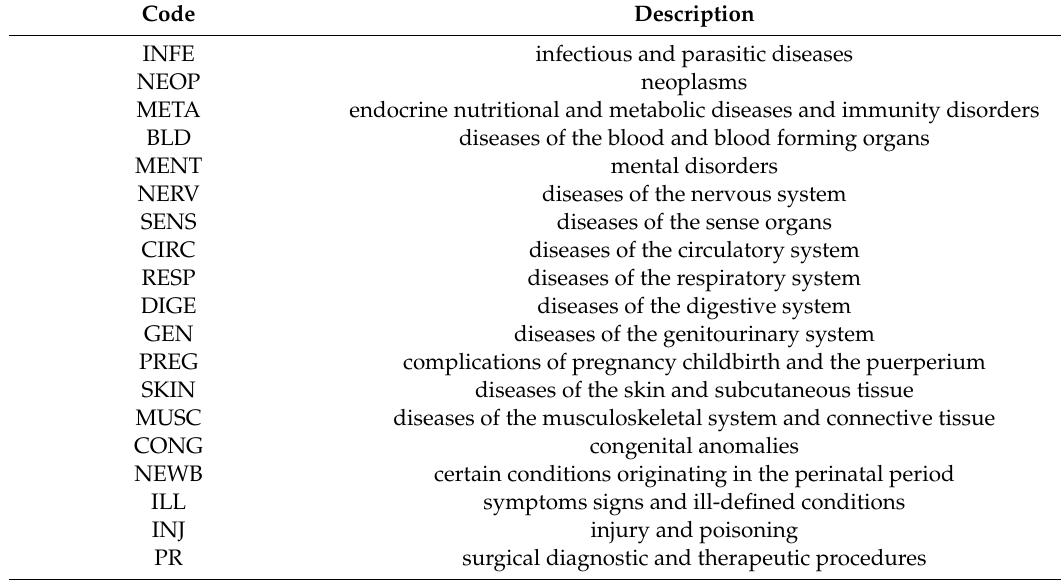
Table 4. ICD-9-CM group codes and description.